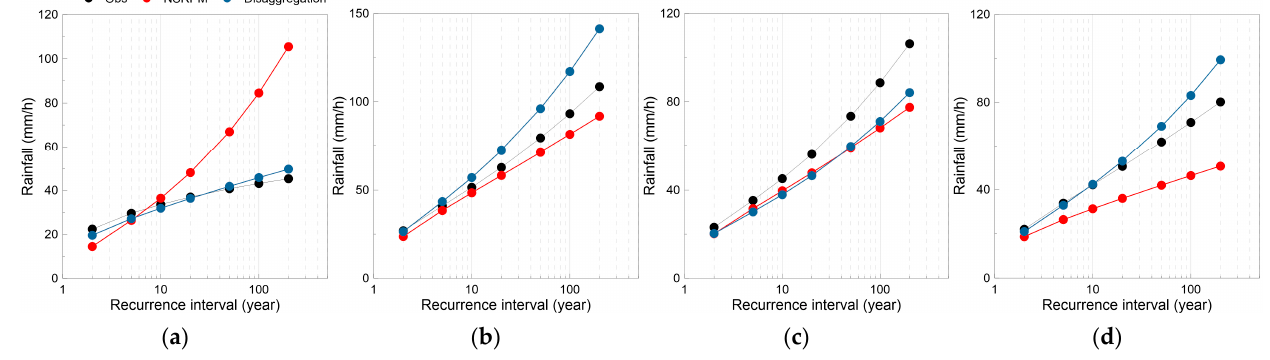
Figure 8. Comparison of T-year recurrence interval (2~200 years) rainfalls from the observed (black), NSRPM (Red), and disaggregation (Blue) rainfalls. ( a ) Ulsan, ( b ) Busan, ( c ) Changwon, and ( d ) Miryang.